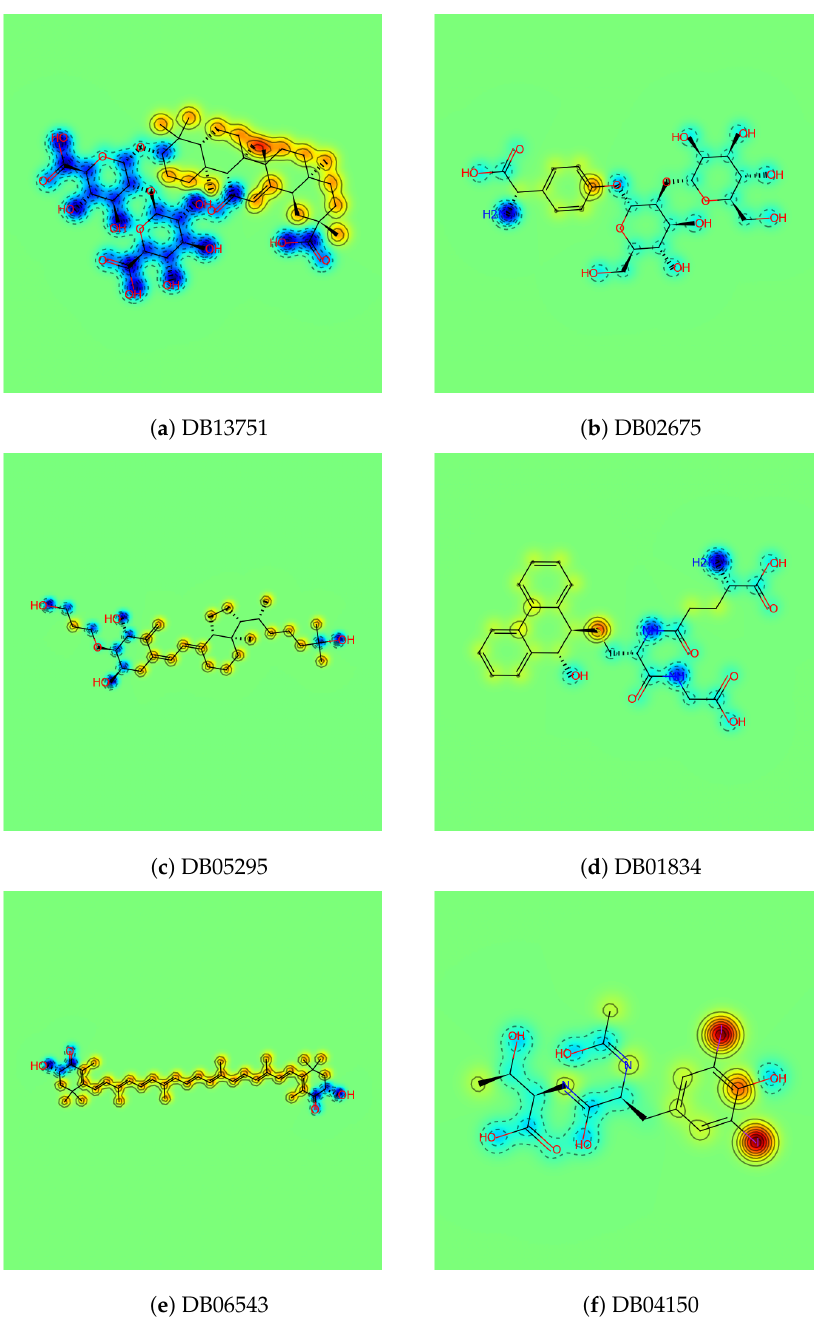
Figure 1. Six final carrier candidates found by the CSS method and qualitative examination. The color on the similarity maps represents the atom-wise partition coefficient logP: the blue area indicates the hydrophilic atoms having low logP, and the red indicates the hydrophobic atoms having a high